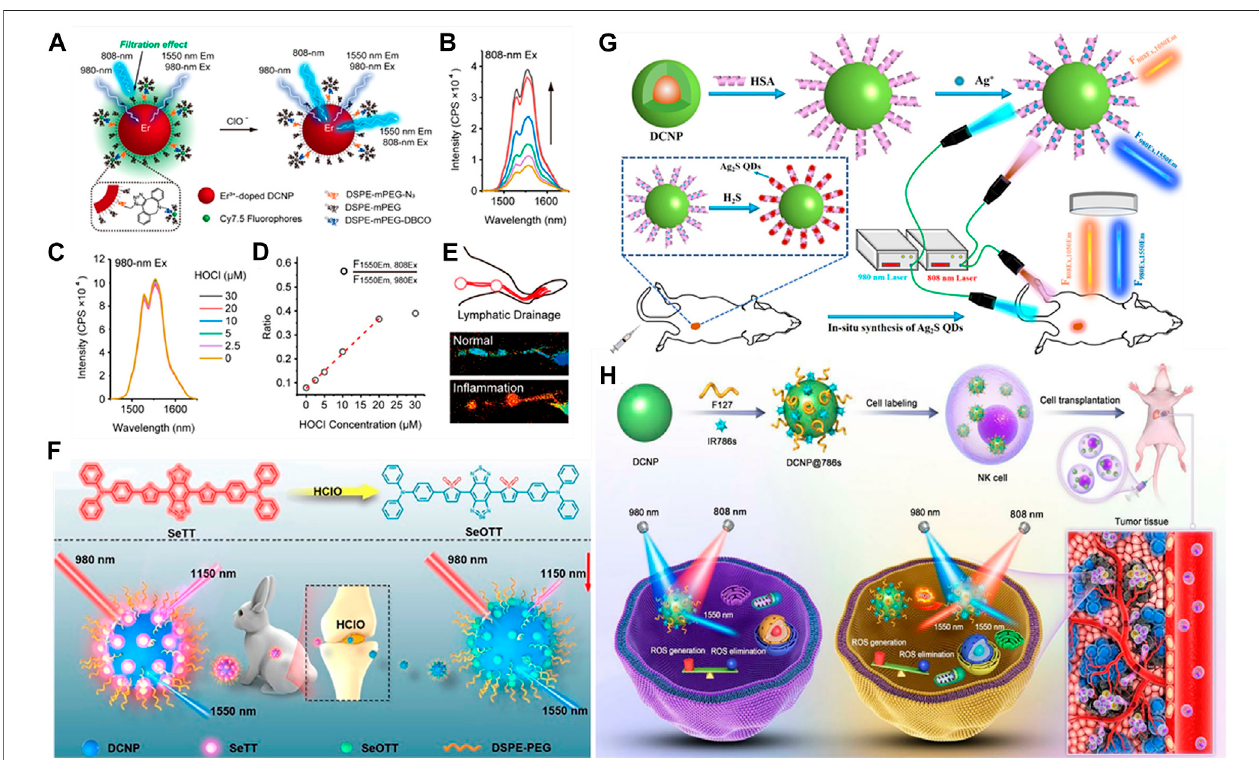
FIGURE6| ExamplesofNIR-IIratiometric fl uorescenceimagingfor invivo quantitative analysis. (A) SchematicillustrationshowingtheratiometricresponseofNIR- II fl uorophore DCNP@Cy7.5 to HClO based on an ACIE mechanism. Er 3+ -doped DCNP: NaEr x Y 1 - x F 4 @NaYF 4 (x (cid:1) 0.05, 0.15, 0.5). (B,C) Fluorescence spectra of DCNP@Cy7.5 (10 μ M Cy7.5) upon addition of 0 – 30 μ M HClO under 808 and 980 nm excitation, respectively. (D) Plot of fl uorescence ratio changes as a function of HClO concentration. (E) Anatomical structures of lymphatic in fl ammation in ratiometric channel are clearly observed with a precise resolution (reproduced from (Wang et al., 2019b) withpermission from American ChemicalSociety). (F) Schematic illustration showing theratiometric responseofNIR-II fl uorophoreDCNP@SeTT@ PEG: DCNP encapsulated with SeTT and PEG. (reproduced from (Ge et al., 2020) with permission from American Chemical Society). (G) Schematic Illustration of the Design of NIR-II Ratiometric FL Nanoprobe for the Detection of H 2 S in Colon Cancer Tissues in vivo . (reproduced from (Wang et al., 2021c)with permission from American Chemical Society). (H) Schematic illustration of DCNP@786s with ratiometric NIR-II fl uorescent signal for tracking NK cell viability in vivo . (reproduced from (Liao et al., 2021) with permission from